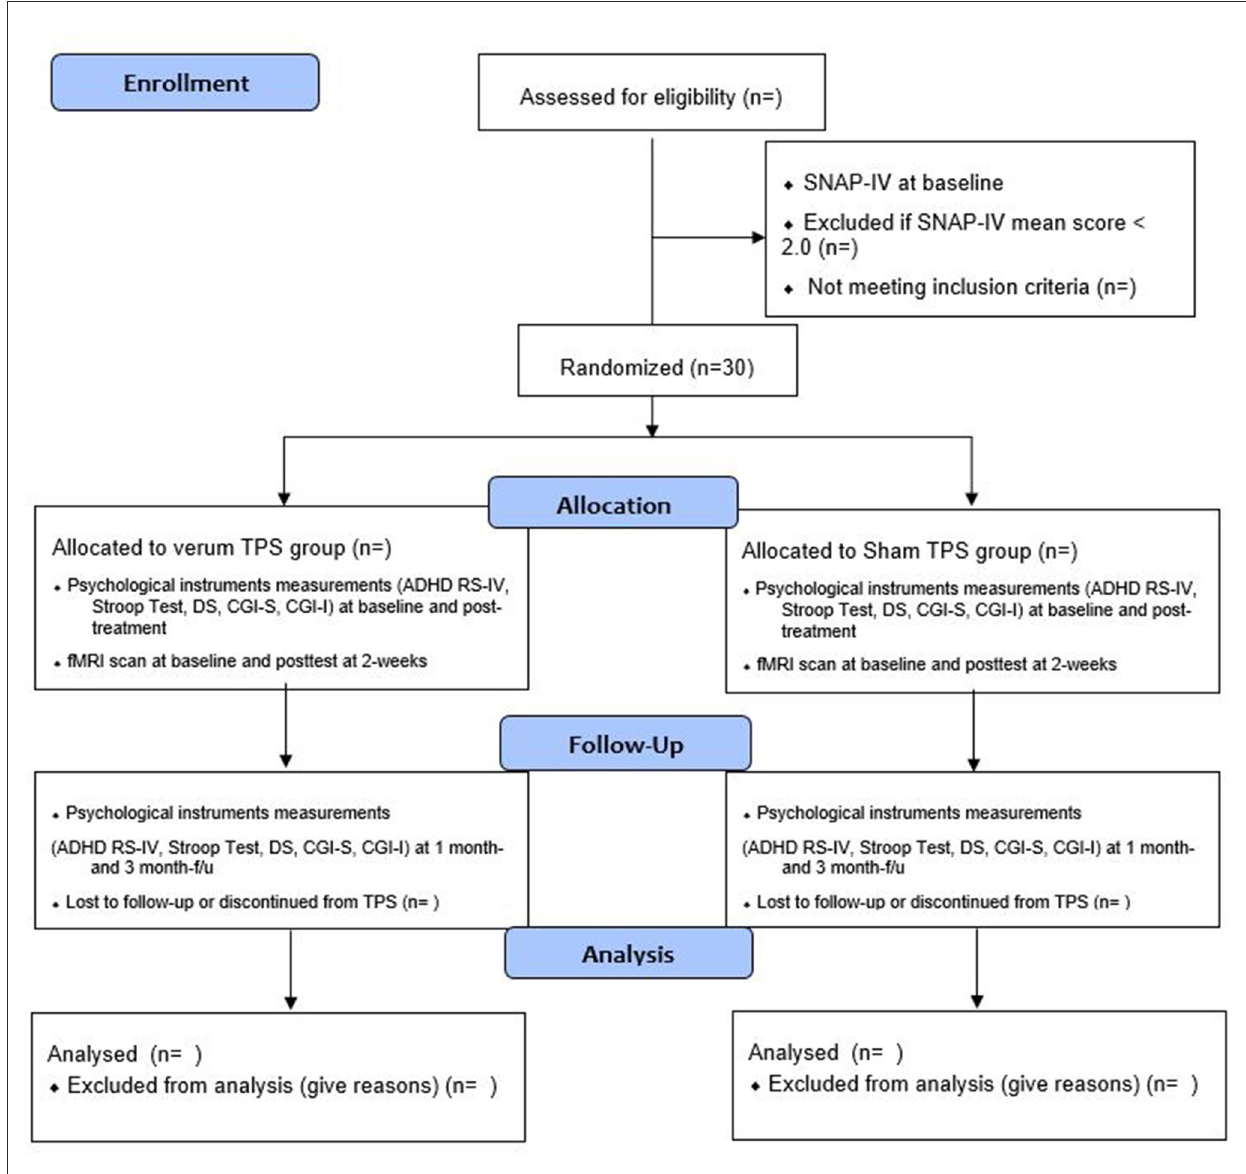
FIGURE1 Flow diagram for subjects’ enrollment, randomization, allocation, and follow-up.